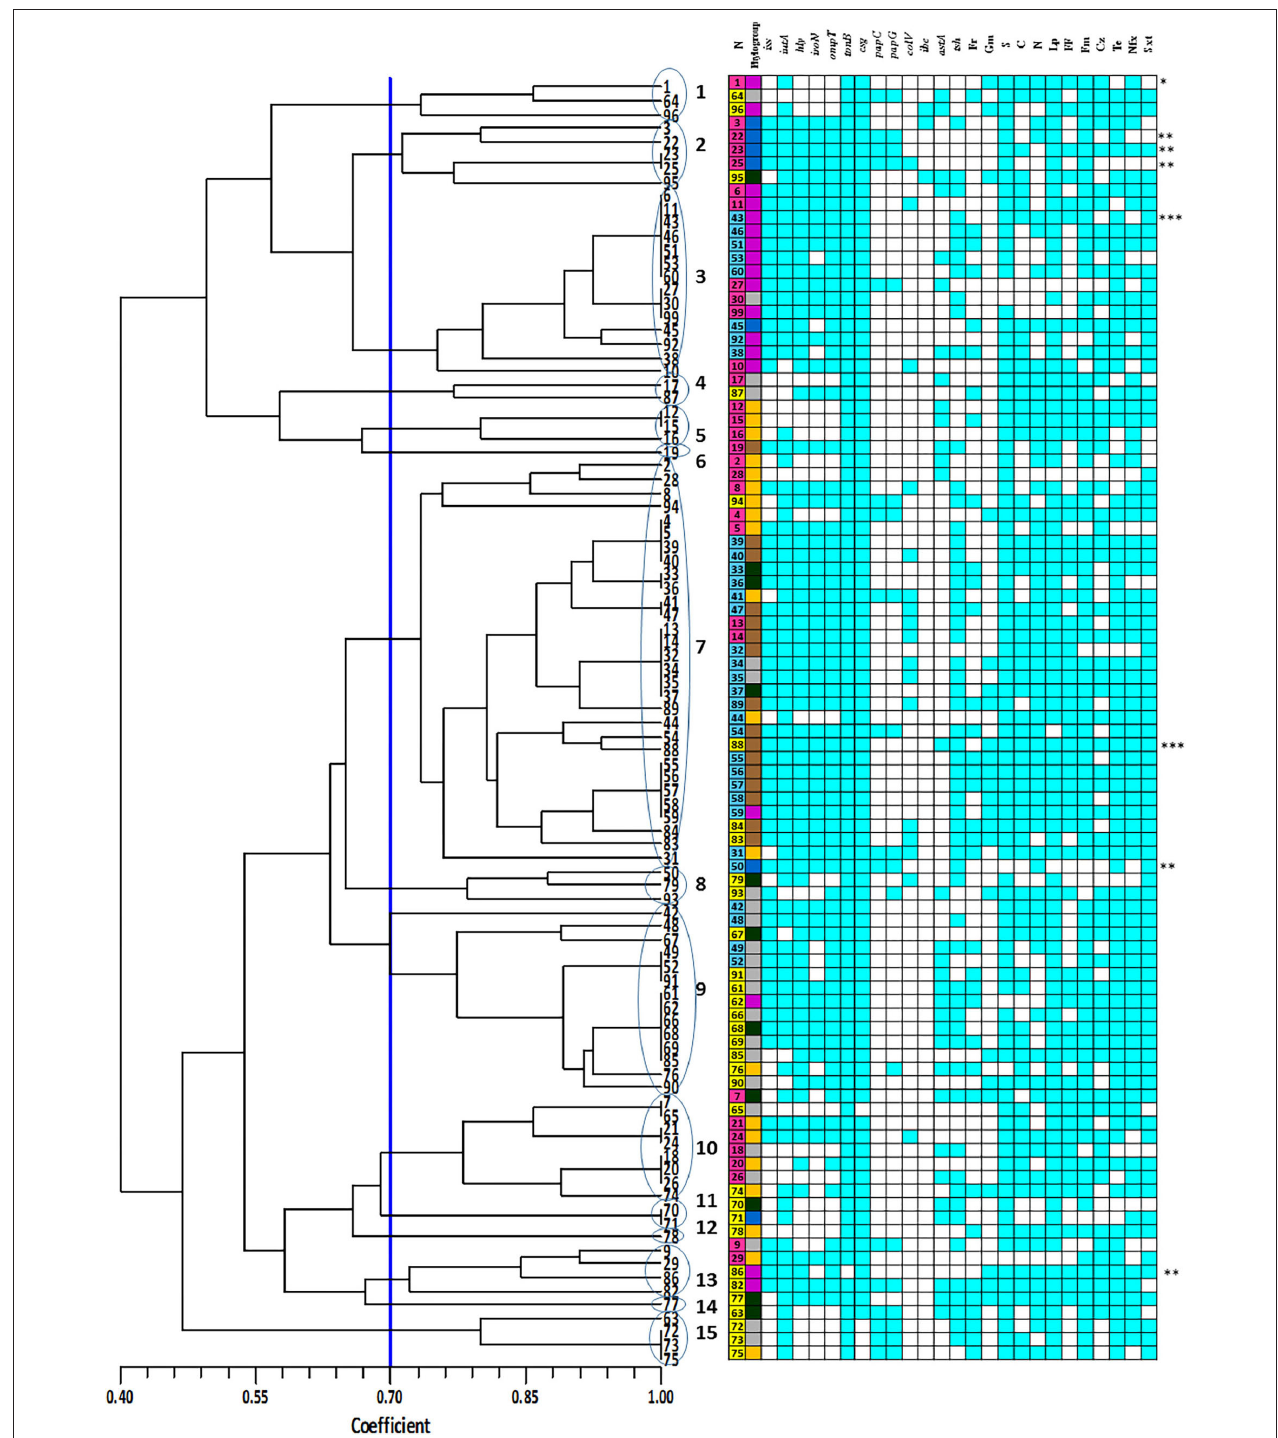
FIGURE 3 | Enterobacterial repetitive intergenic consensus (ERIC) denderogram of Escherichia coli strains drawn using unweighted-pair group method with arithmetic mean (UPGMA). Based on a similarity index of 70% (blue line), 15 major clusters (shown by Arabic numbers) were found. Numbers at the terminal branches are strain name. The colors mean as follows: : Yolk sac infection strains; : Colisepticemia strains; : Fecal strains; : phylogroup F; : phylogroup A; : phylogroup B2; : phylogroup E; : phylogroup B1; : phylogroup C; Gm: gentamycin; S: streptomycin; N: neomycin; Lp: lincospectin; Fm: flumequine; Cr: chloramphenicol; Nfx: enrofloxacin; Sxt: sulfamethoxazole-trimethoprim; Te: tetracycline; Fr: florfenicol; Blue boxes indicate positive resistance phenotype or presence of virulence-associated gene. *: O1; **: O2; ***: O78.